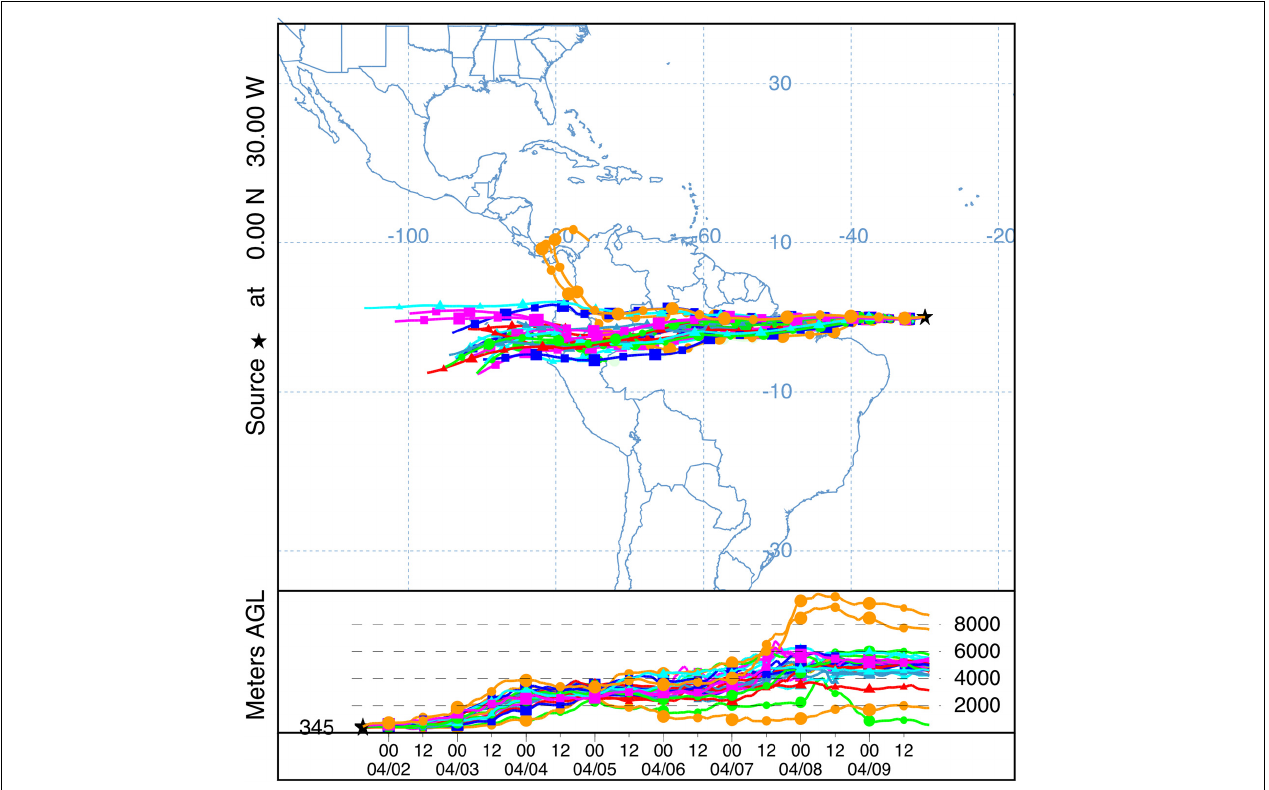
FIGURE 3 | An airmass traveling from the Atlantic to the Pacific was tracked using NOAA Air Resources Laboratory HYSPLIT (Stein et al., 2015; Rolph et al., 2017) forward trajectory ensemble model with a starting point at 0 ◦ N, 30 ◦ W (black star) over 7 days (04/02/2020 –04/09/2020) with global forecast system (GFS) meteorology data. Each possible trajectory is represented with each point along the trajectory corresponding to a 12-h increment. The estimated mid-boundary layer height was added (345 m) at the starting point (black star) and the height (m) above ground level (AGL) is shown for each trajectory. Multiple colors enables individual trajectories to be